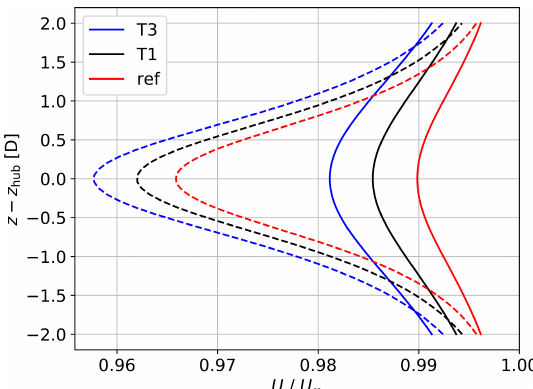
Figure 5. Upstream vertical velocity profiles extracted from RANS–CFD at 1D (dashed lines) and 2D (continuous lines) of the isolated case, T1 and T3 for U ∞ = 8ms − 1 and θ = 0 ◦